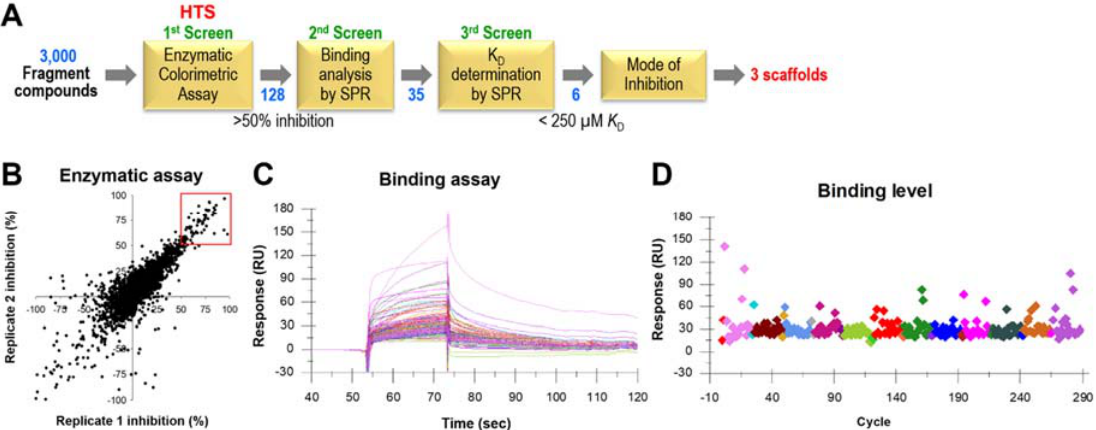
Figure 2. High-throughput screening results of SaDHOase with Chembridge fragment library. ( A ) Schematic representation of overall HTS and hit validation process. ( B ) Replicate plot of the primary HTS of 3000 fragment compounds from specially selected Chembridge by enzymatic assay, resulting in 128 hits highlighted in the red box. ( C ) Overlaid surface plasmon resonance (SPR) sensorgrams of 128 hit compounds directly binding to the immobilized SaDHOase at a single concentration (400 µ M). ( D ) Binding level at 10 s before injection ended after zero concentration signal subtraction.